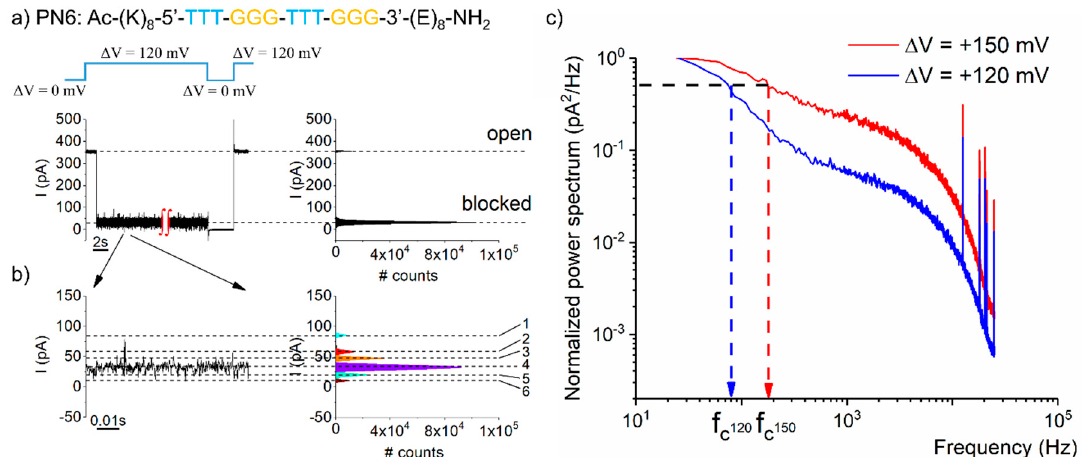
Figure 4. The fluctuation kinetics of the residual current through the α -HL-PNA system were voltage-dependent. ( a ) Ex- cerpted segment from a recording made at ∆ V = +120 mV, capturing a PN6 (K 8 –T 3 –G 3 –T 3 –G 3 –E 8 ) PNA-induced blockade event on the ionic current mediated by the α -HL. The expanded trace in ( b ) displays the fluctuations making up the resid- ual current through the α -HL while blocked by the PNA. ( c ) Representative normalized power spectra of residual current fluctuations entailed by a PN6 PNA lodged inside the α -HL, recorded at two distinct potentials.